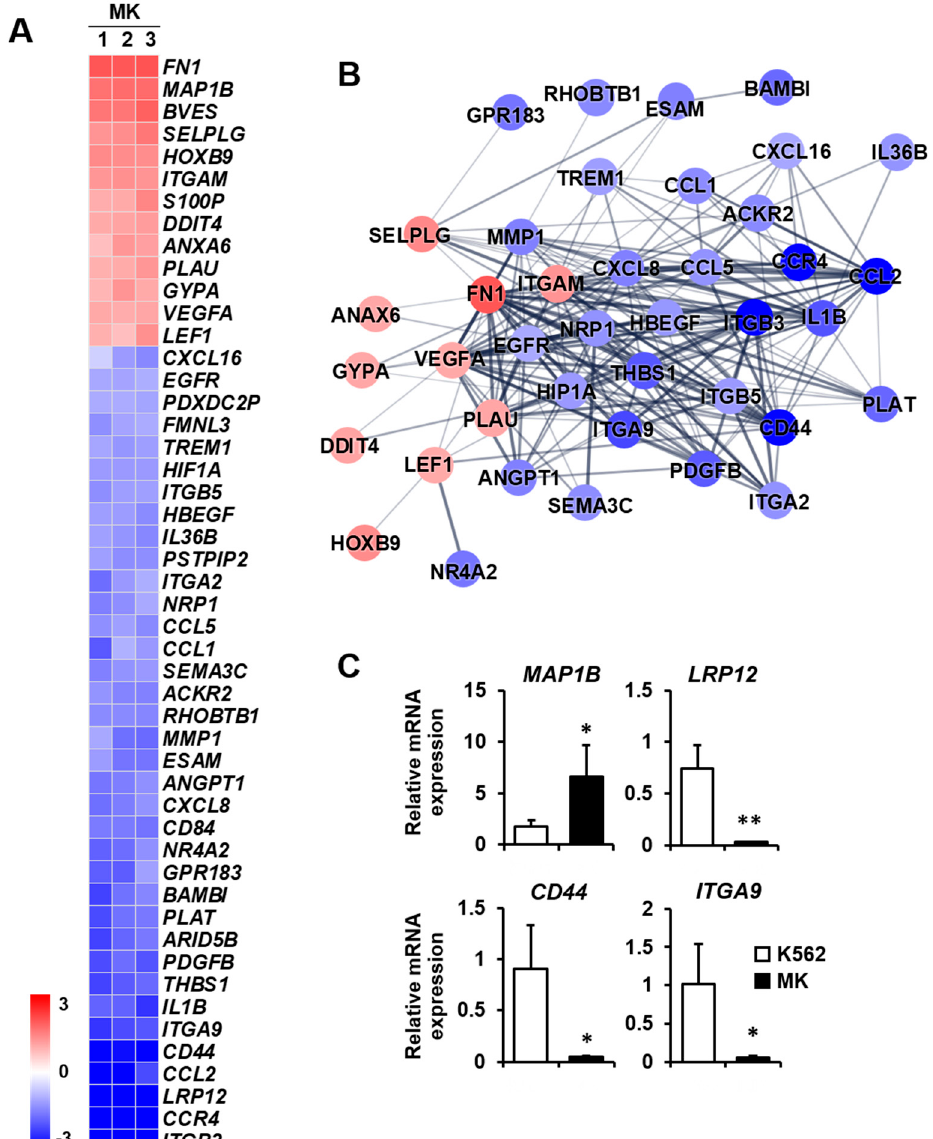
Figure 5. Expression levels by z-scores of genes included in the cell migration cluster and the relationship between constituent genes. ( A ) Heat map of genes differentially expressed in megakaryocytes (MKs) compared with K562 cells based on the microarray analysis. The red color indicates upregulation and the blue color indicates downregulation. The degrees of colors represent the expression levels of the genes. ( B ) Protein–protein interaction analysis using the STRING database. The red and blue colors denote upregulation and downregulation, respectively. The higher the confidence in the interaction, the greater the line thickness between the proteins. Members without interaction with other genes were excluded from the STRING database analysis. ( C ) Validation of the mRNA expression of selected genes ( MAP1B, LRP12, CD44, and ITGA9 ) differentially expressed in MKs by qPCR. Relative expression levels were plotted against gene expression levels in K562 cells. Data are presented as the mean ± standard deviation of three independent experiments. Please see abbreviations for the full names of genes. *, p < 0.05; **, p < 0.01 versus K562